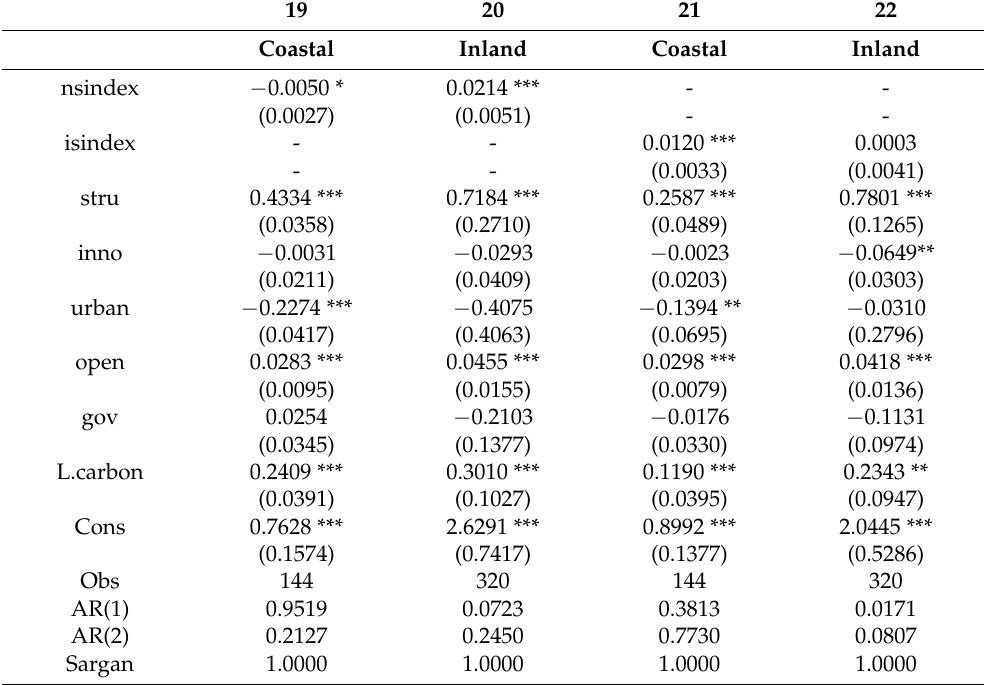
Table 5. Comparison of regional differences in carbon-emission